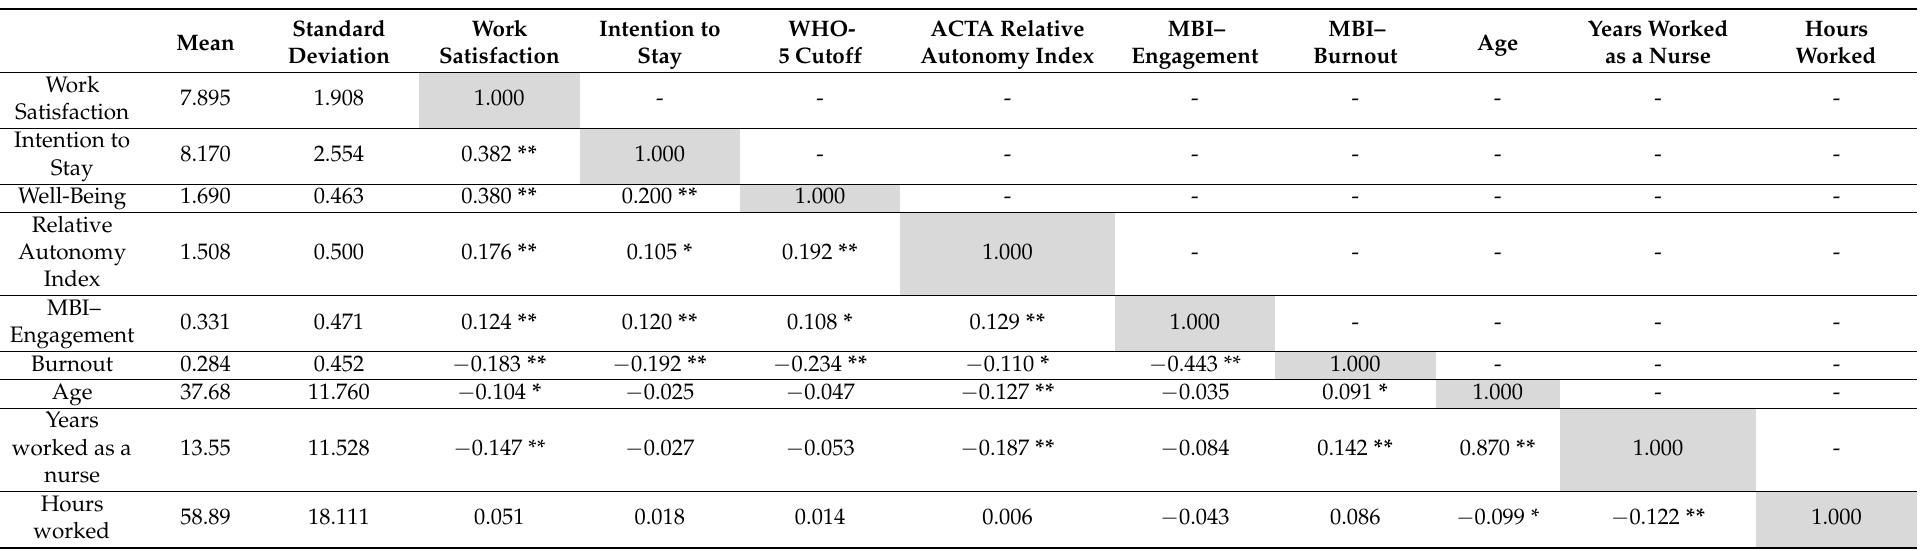
Table 2. Descriptive Statistics and Correlation Matrix–Spearman’s rho (N =